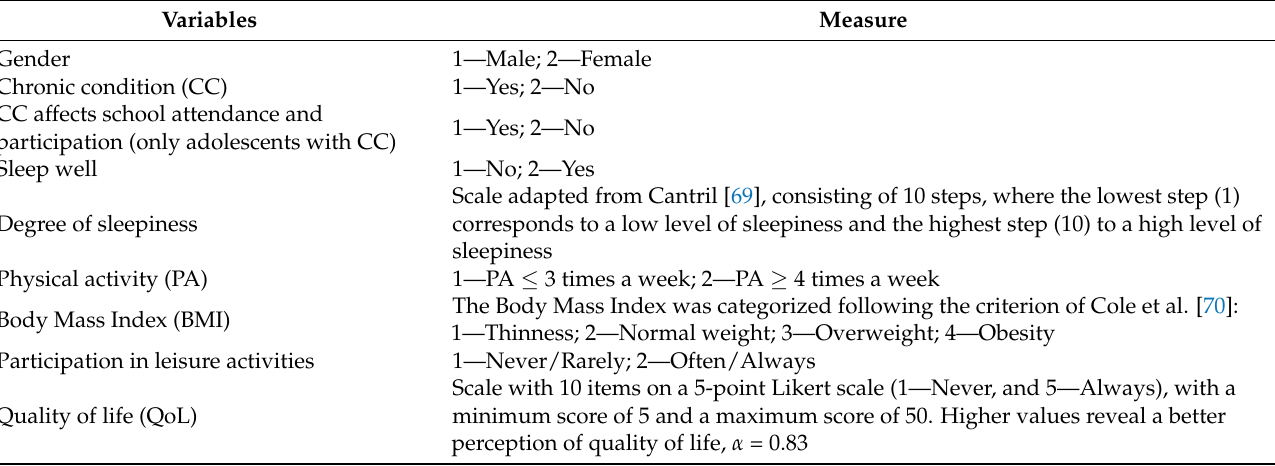
Table 1. Measures and variables under